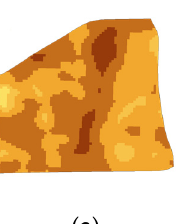
Figure 11. Optimized landscape index. ( a ) LSI. ( b ) C. ( c ) SHDI. ( d ) Den.